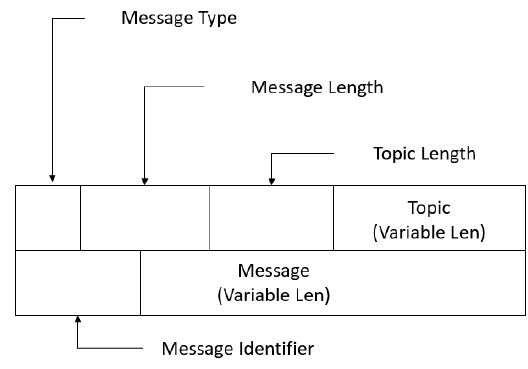
Figure 6. Publish packet structure.